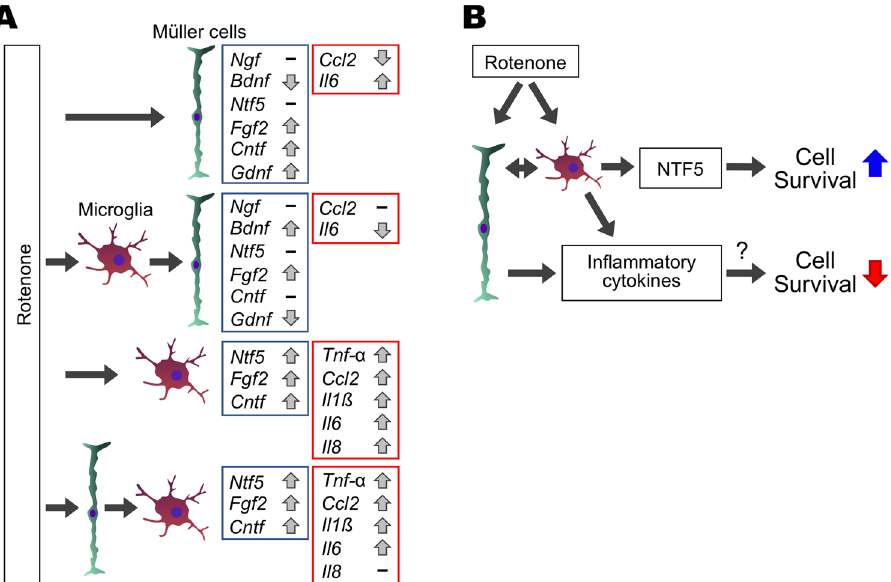
Figure 6. Schematic diagram explaining glial roles in rotenone-induced retinal degeneration. ( A ) Summary of expression changes in growth factors and inflammatory cytokines in Müller and BV-2 cells stimulated with rotenone or rotenone-stimulated cell-conditioned media. Gene expression changes of growth factors and inflammatory cytokines were shown in the boxes colored blue and red, respectively. ( B ) Positive and negative effects of rotenone-stimulated glial cells on retinal survival. Expression of inflammatory cytokines is upregulated in rotenone-treated Müller and microglial cells. These would result in a decreased survival of retinal cells owing to excessive inflammatory responses. In contrast, microglia activate to produce NTF5 in response to rotenone or secretion of rotenone-treated Müller cells, which leads to increased survival in retinal cells owing to its neuroprotective